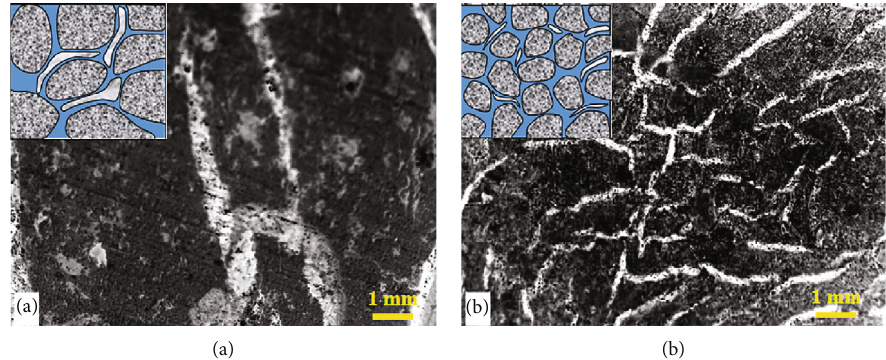
Figure 12: Macrocryo-structures of frozen soils with particle dispersions 2 (a) and 1 (b) surrounding a pile.